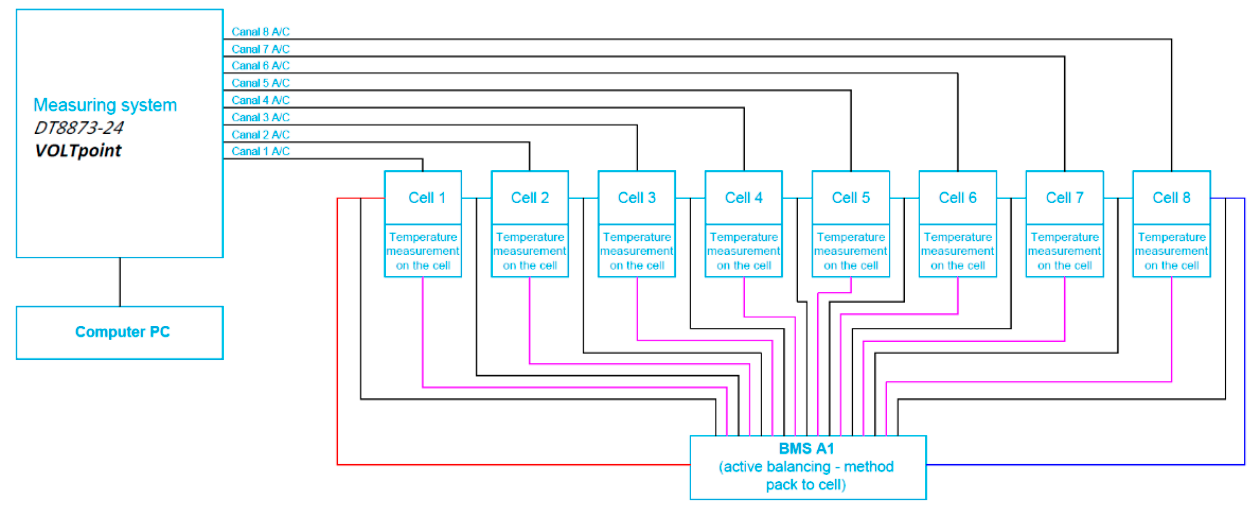
Figure 10. Block diagram of the cell measurement system for the battery with connected BMS with active balancing, the battery-to-cell method.